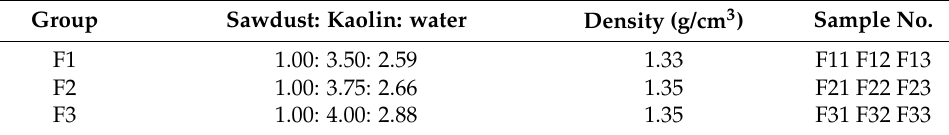
Density (g/cm 3 ) Sample No.